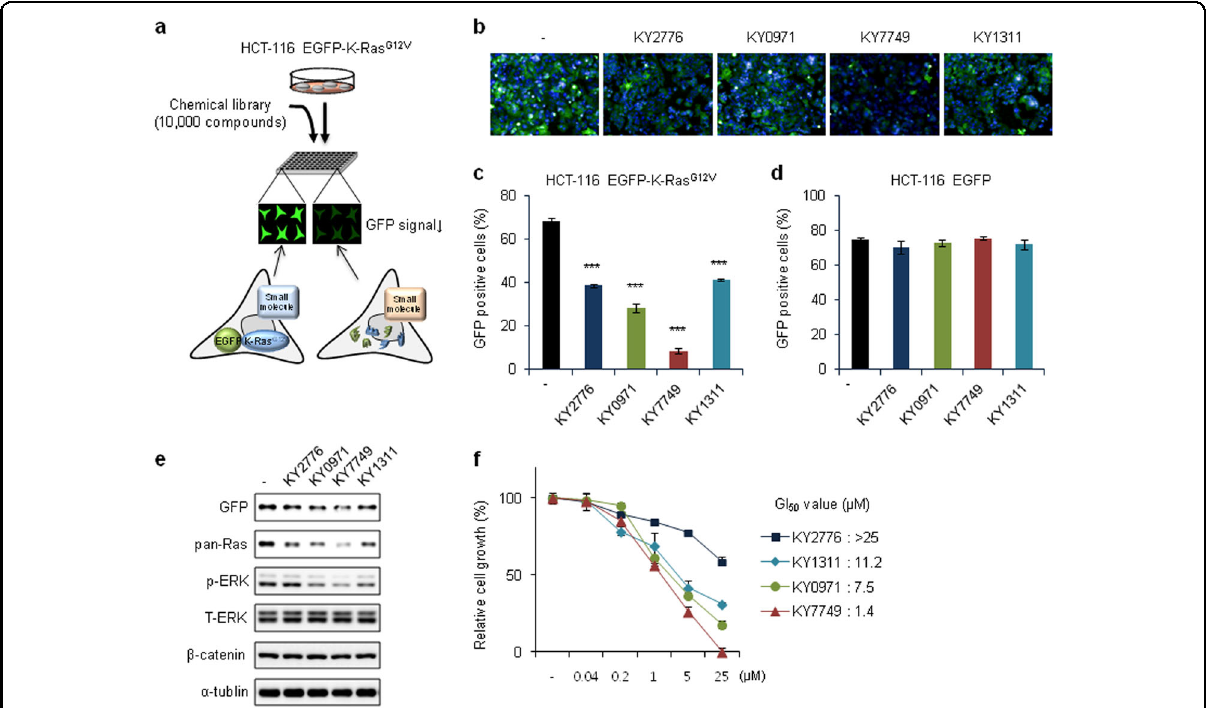
Fig. 1 High-content screening (HCS) and characterization of small molecules that degrade oncogenic K-Ras in CRC cells with CTNNB1 mutations. a A schematic of the method used to identify small molecules that degrade mutant K-Ras (G12V) in HCT-116 cells expressing nondegradable mutant β -catenin. The established HCT-116 EGFP-K-Ras G12V cells were cultured in 384-well plates, and small molecules that reduced the green fl uorescent protein (GFP) signal were selected as initial positive hits, as described in the results. b Fluorescent images from four representative hit compounds selected by HCS. c , d Flow cytometry analysis of the four hit compounds based on fl uorescence of HCT-116 EGFP-K- Ras G12V ( c ) or HCT-116 EGFP ( d ) cells treated with 10 μ M of each compound for 24 h (mean ± SD, n = 3). e Immunoblot analyses of HCT-116 EGFP-K- Ras G12V cells treated with 10 μ M each of the four hit compounds for 24 h. f MTT [3-(4,5-dimethylthiazol-2-yl)-2,5-diphenyltetrazolium bromide] assays in HCT-116 EGFP-K-Ras G12V cells treated with different concentrations of each hit compound for 96 h (mean± SD, n = 3). Relative cell proliferation was normalized to dimethyl sulfoxide (DMSO)-treated controls and 50% growth inhibition (GI 50 ) was calculated. Whole cell lysates (WCLs) from each of the cells were immunoblotted with antibodies against the indicated proteins ( e